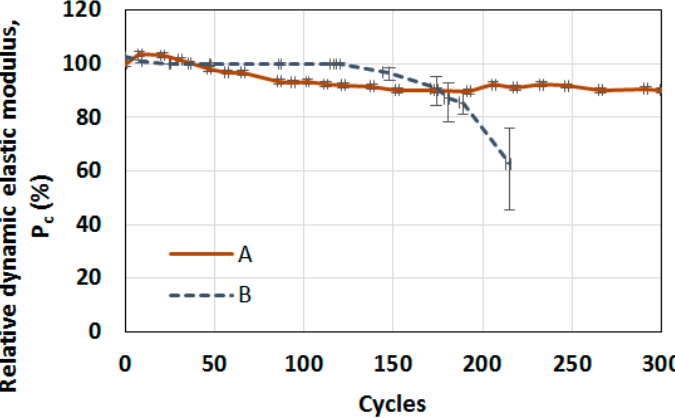
Figure 4. The relative dynamic modulus of elasticity in each cycle for a comparison between samples A and B .